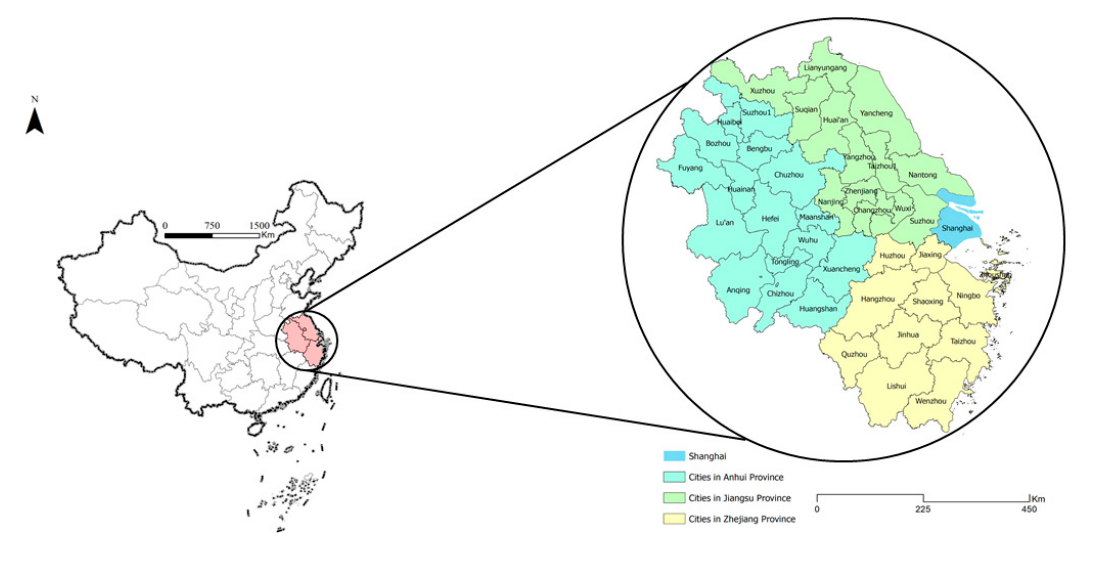
Figure 2. Location of the Study